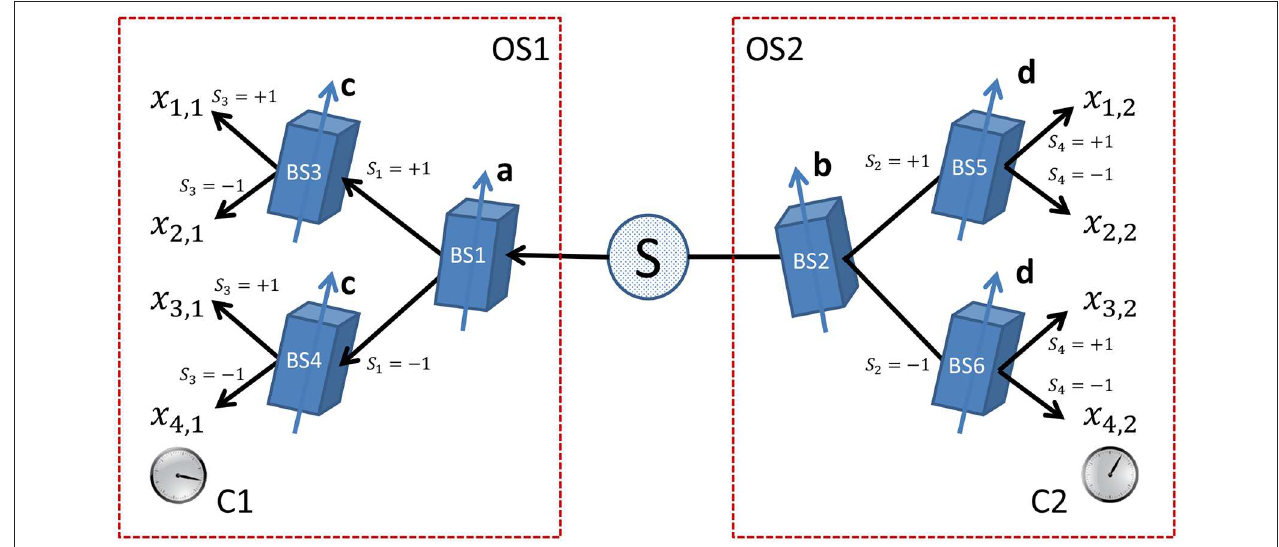
FIGURE 1 | Layout of the extended Einstein-Podolsky-Rosen-Bohm experiment with spin-1/2 particles emitted by the source S. The observation station OS1 (OS2) contains three beam splitters BS1, BS3, and BS4, (BS2, BS5, and BS6) and a clock C1 (C2). The directions of the beam splitters BS1, BS2, BS3, BS4, BS5, and BS6 are represented by vectors a , b , c , c , d , and d , respectively.